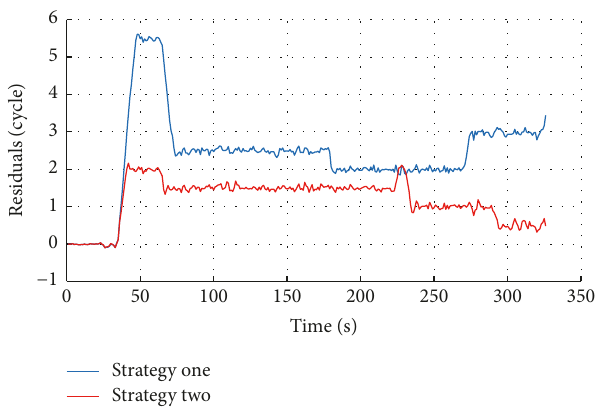
Figure 13: Residuals of satellite PRN 27 using two processing strategies.